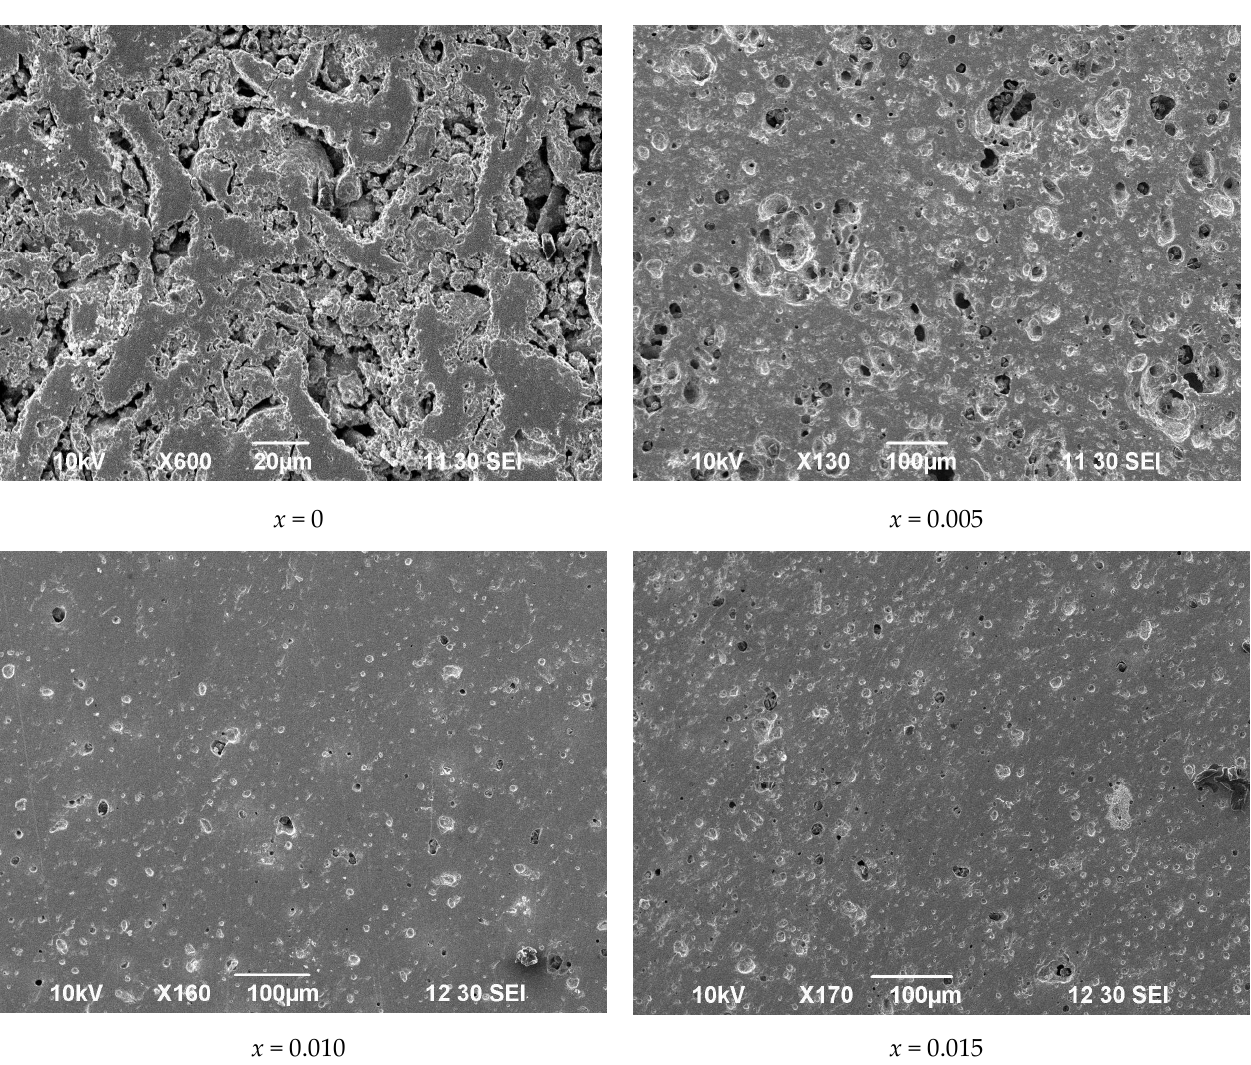
Figure 5. Scanning electron microscopy images of La 0.5 − x Sr 0.5 FeO 3 − δ ceramics sintered at 1300 °C. Table 2. Relative density of La 0.5 − x Sr 0.5 FeO 3 − δ ceramics.